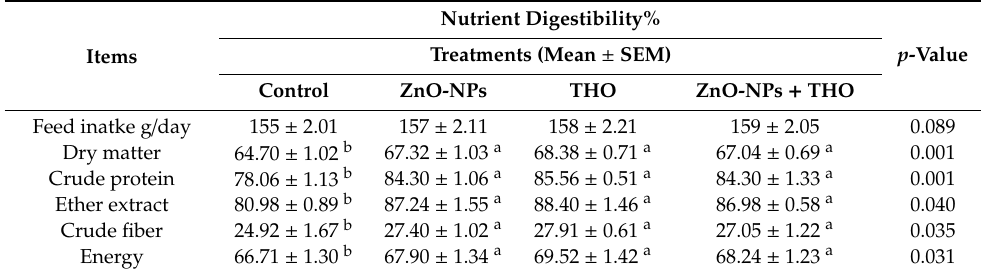
Table 3. E ff ect of nanoparticles-zinc oxide (ZnO-NPs; 100 mg / kg), thyme oil (THO; 500 mg / kg) and their combination (ZnO-NPs; 100 mg / kg + THO 500 mg / kg) on nutrient digestibility of male rabbits. Letters (a, b, c) denote the significant di ff erences between the